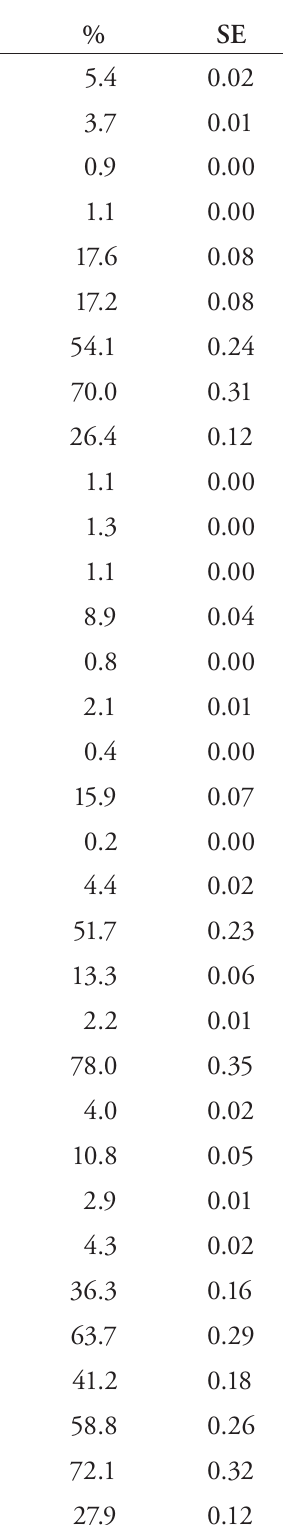
Table 1. Descriptive Statistics for the